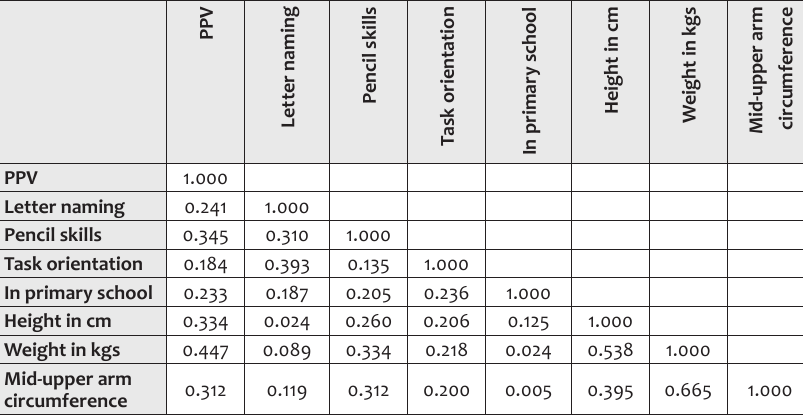
Table 3: Correlation of outcome measures PP